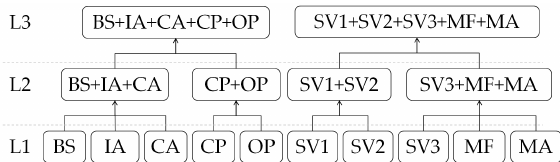
Figure 2. Legend levels. Notes: BS = Bare Soil, IA = Idle Agricultural Area, CA =